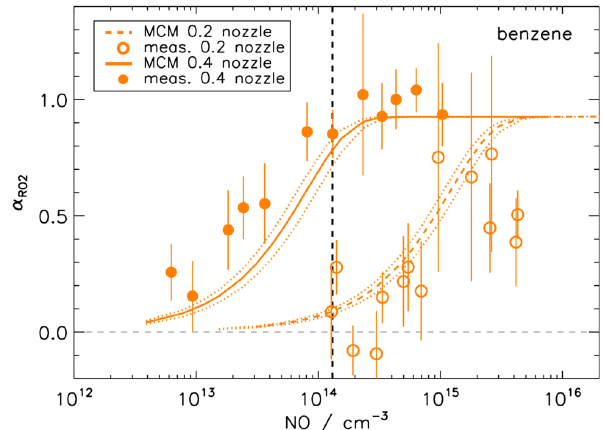
Fig. 6. Same as Fig. 4, but for RO 2 radicals produced by benzene and OH. Measurements take 65% of prompt HO 2 formation in the radical source into